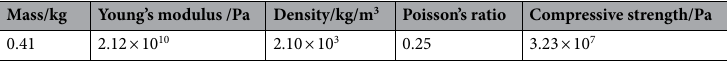
Table 1. Mechanical parameters of concrete 29 .